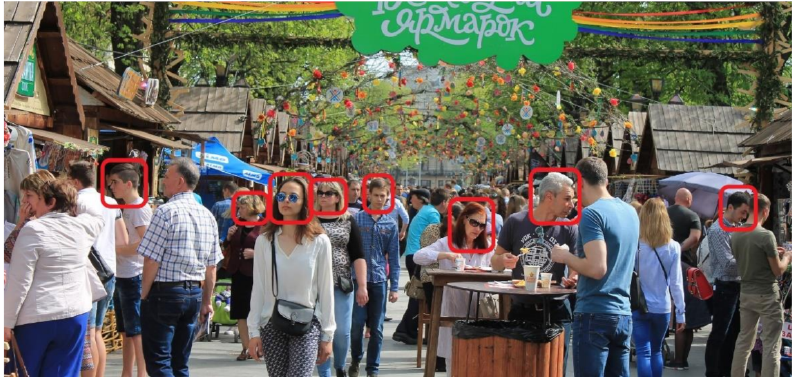
Figure 5. The face recognition algorithm applied to a frame of a crowd at a country fair. The average number of faces detected per frame is used to estimate the people density in the area. This public image has been chosen to illustrate the concept to be represented. In order to comply with data protection legislation, actual security camera footage has not been